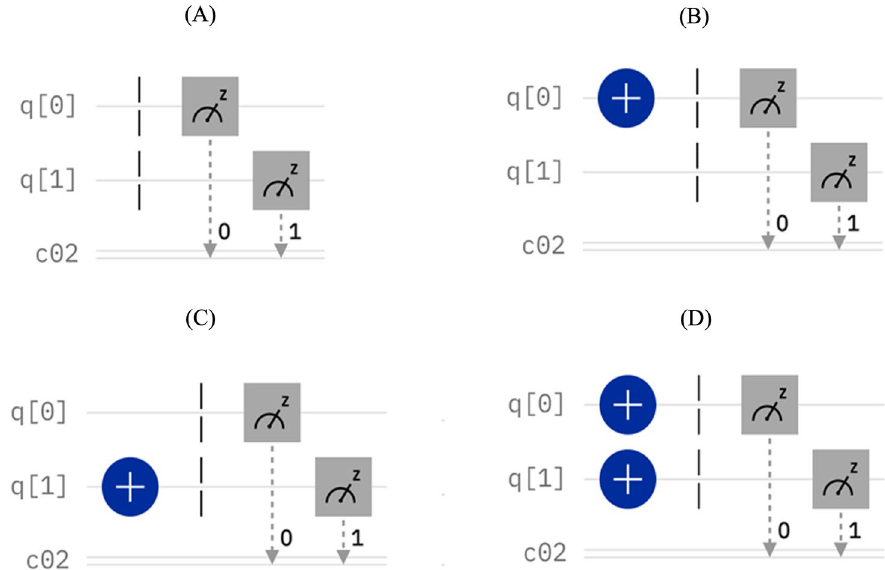
Fig. 5 The four circuits used to construct the calibration matrix for the error